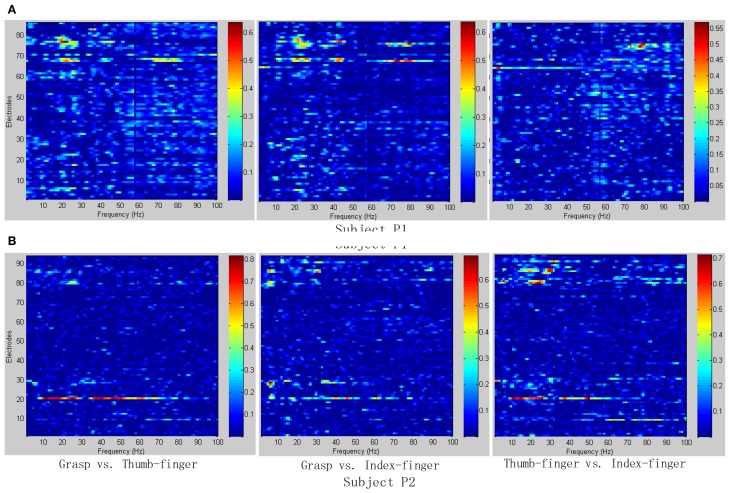
R2-values for Subject P1 and P2 with two different combinations of classes (Grasp vs. Thumb-finger, Grasp vs. Index-finger, Thumb-finger vs. Index-finger) during seizure monitoring. The power spectrum shown here was calculated with a frequency bin width of 1 Hz for each electrode. The selected frequency bins of P2 with combination of thumb-finger and index-finger, for example, were 64, 65, 97, 98, 99 within electrodes 3, 4, 9, 10, 16. (A)
R2-values of Subject P1; (B)
R2-values of Subject P2.